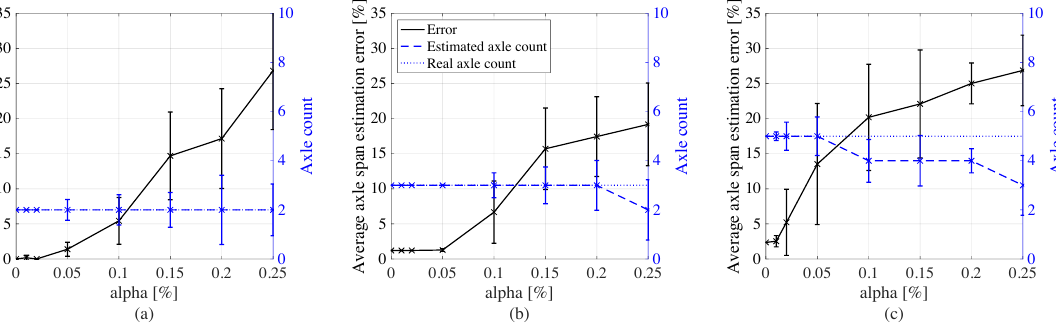
Figure 9. Axle span-to-vehicle length estimation errors (with +/- standard deviation intervals) as functions of noise level for: ( a ) type 1 truck; ( b ) type 2 truck; and ( c ) type 3